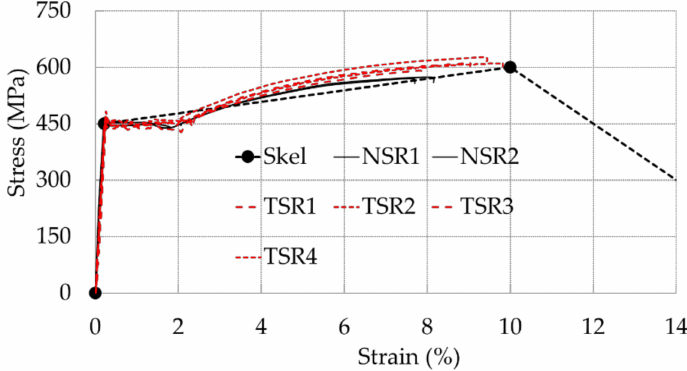
Figure 8. New rebar segments tested in tension: Not turned (NSR) and turned (TSR) segments; skeleton curve (Skel) to calibrate the steel material model in